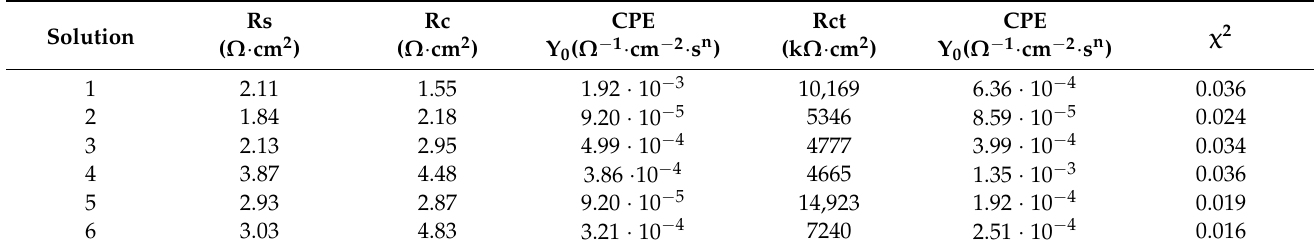
Figure 7. Nyquist diagram in “High-Frequency Zone” (1 · 10 5 Hz). Table 3. Parameters obtained through Equivalent Circuit of the Nyquist Diagram.